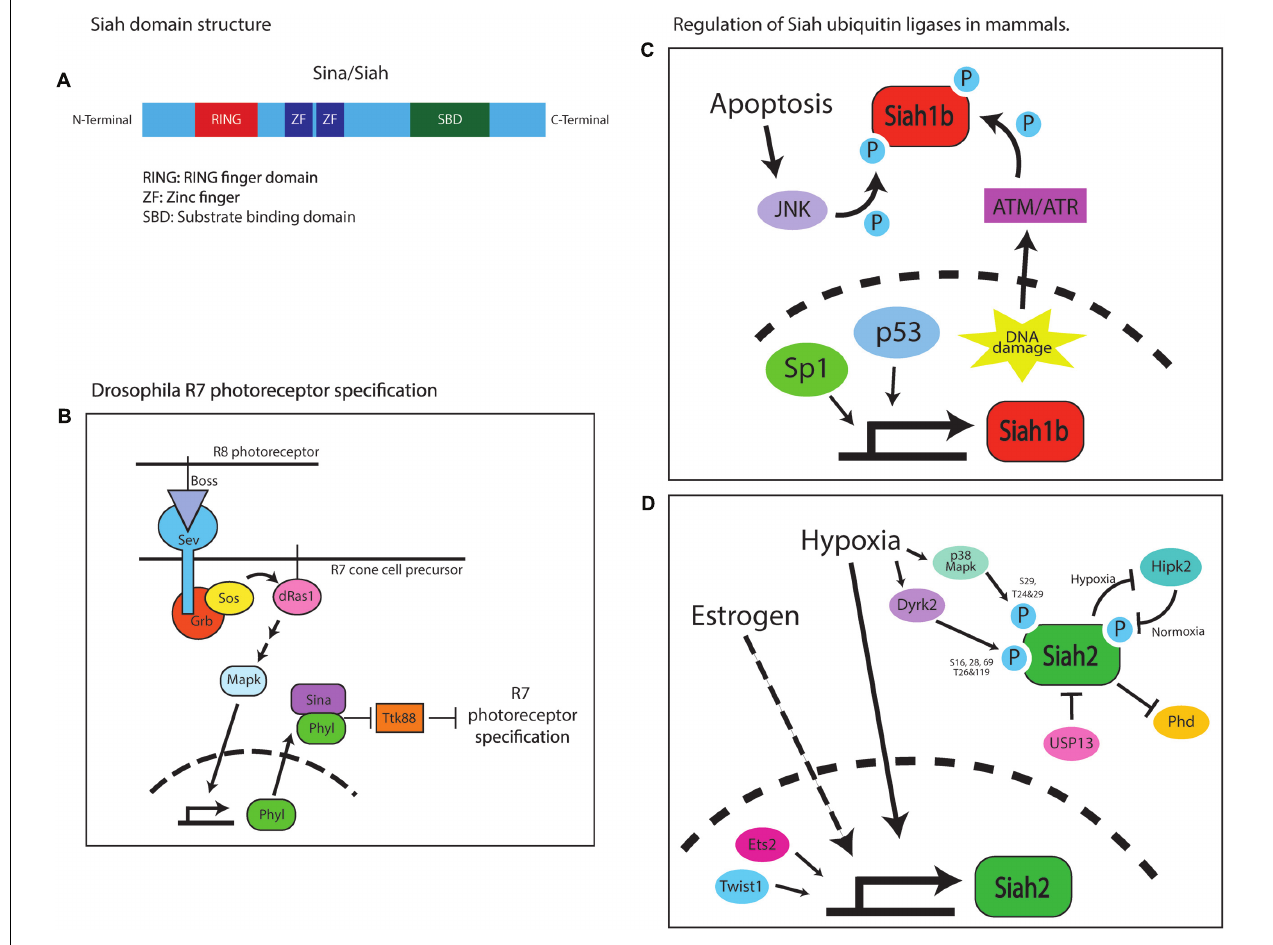
FIGURE 1 | Domain structure of Sina/Siah and its regulation in Drosophila and mammals. (A) Domain structure of Siah E3 ubiquitin ligase. (B) Schematic of the signaling pathway regulating the specification of the R7 photoreceptor. Sina is placed epistatically downstream of the drosophila Ras–MAPK cascade. Boss, bride of sevenless; Sev, sevenless; Grb, growth factor receptor bound protein; Sos, son of sevenless; Phyl, phyllopod; Ttk88, tramtrack88. (C) Schematic of the transcriptional and post-translational pathways involved in regulating Siah1b in mammals. In mice, Siah1b is regulated by p53 while human SIAH1 basal transcription is regulated by Sp1. Post-translationally, Siah1b is regulated through phosphorylation by JNK or ATM/ATM during events of cellular stress like apoptosis and DNA damage. (D) Schematic of the transcriptional and post-translational pathways involved in regulating Siah2 in mammals. Estrogen signaling and hypoxia upregulate Siah2 transcriptionally. Twist1 and Ets2 are transcription factors reported to activate transcription of Siah2. Post-transcriptionally, activity of Siah2 is regulated by phosphorylation by multiple kinases – Dryk2, p38, MAPK, and HIPK2, or via physical interaction with USP13. This figure is all original content.